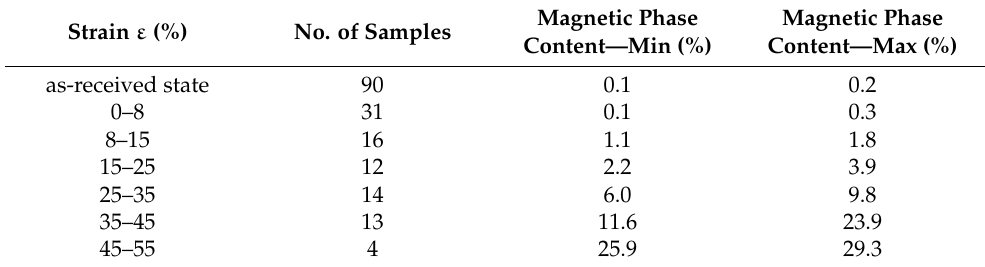
Table 2. Magnetic phase content.